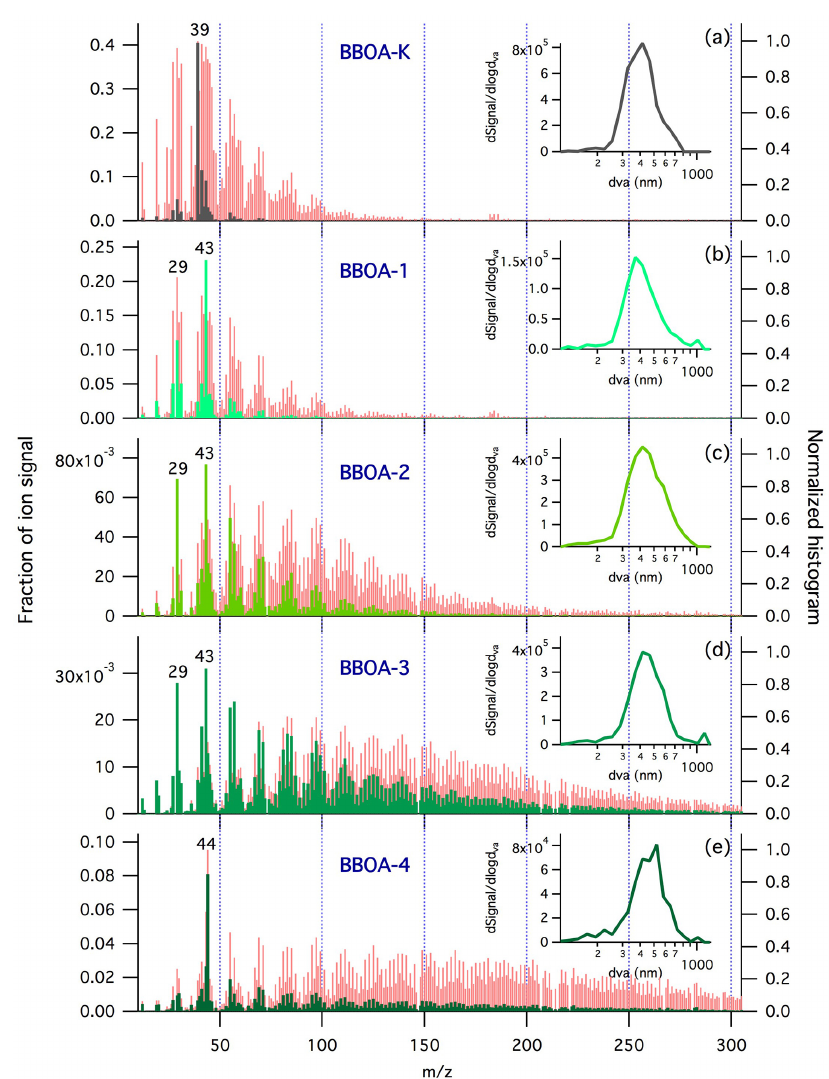
Figure 2. Average mass spectra (left axis, green/grey traces), normalized mass spectral histograms (showing the relative frequency of a signal at each m/z , right axis, red traces), and size distributions (insets) of the five BBOA-related particle classes identified by cluster analysis of LS-SP-AMS